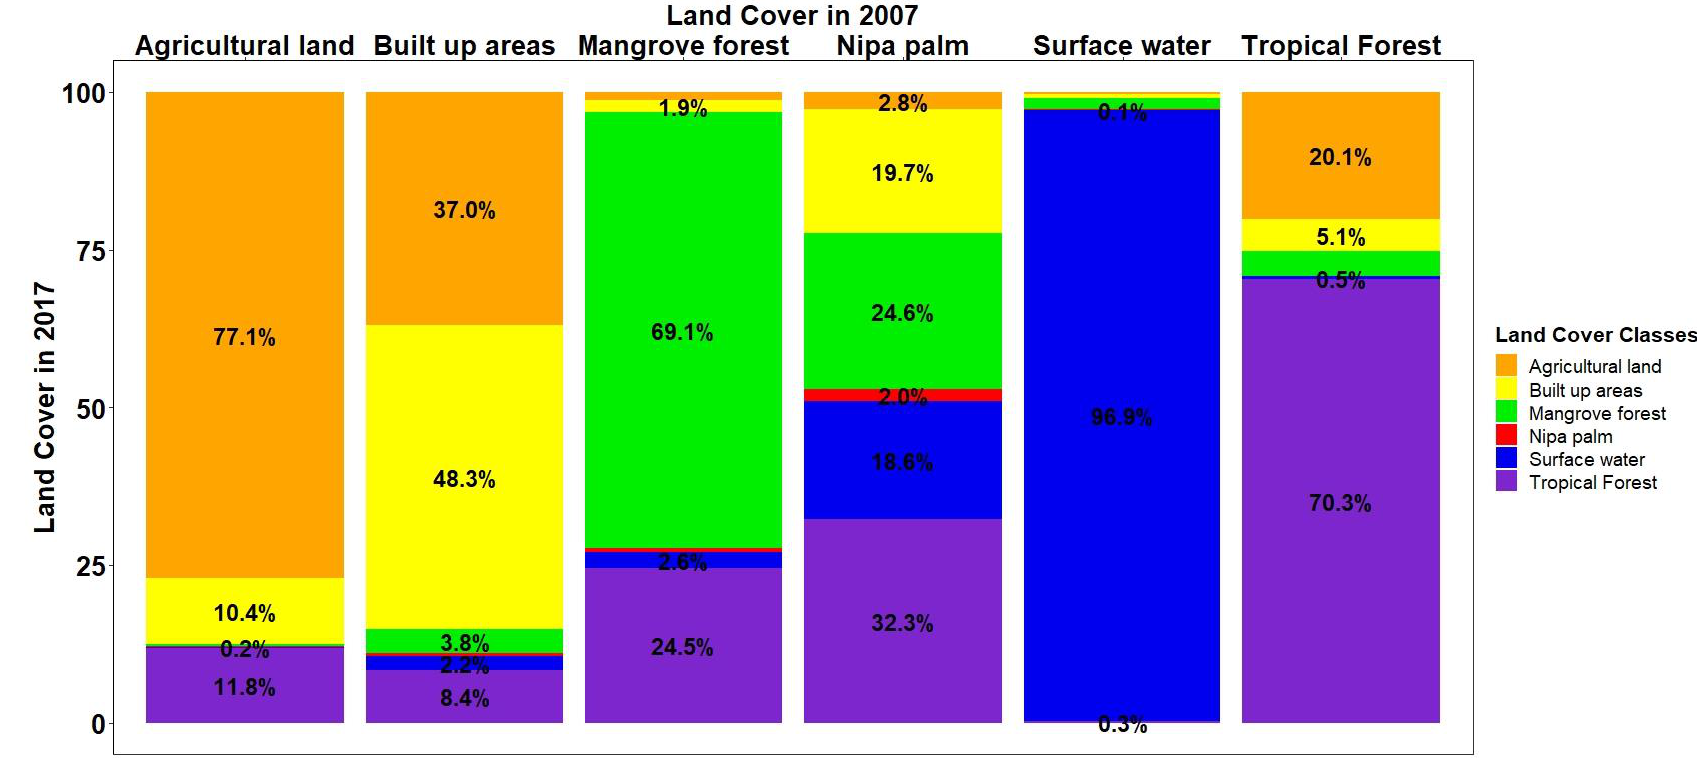
Figure 7 : Percentage change of land cover classes in the Niger Delta between 2007 and 2017. Figure 7. Percentage change of land cover classes in the Niger Delta between 2007 and